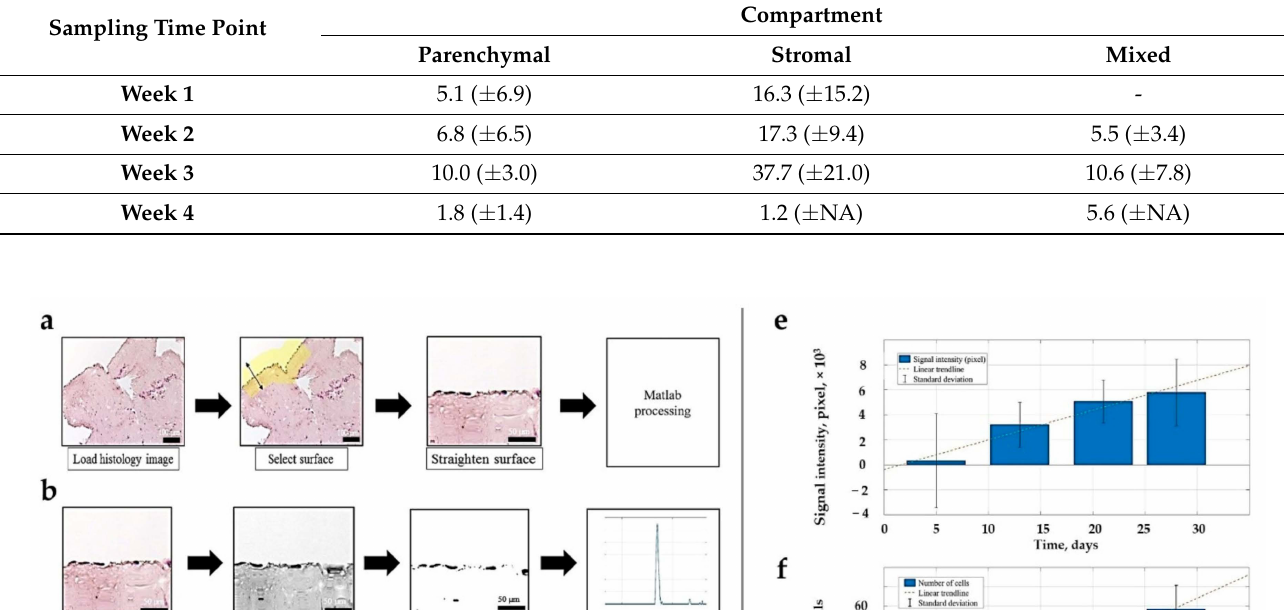
Table A2. Relative cellularity (mean% ± standard deviation of the TEC section area) in different compartments of the liver ECM measured as a ratio of cells to matrix area: Results of image analysis of histological sections. Ten images were analyzed for each timepoint/compartment.